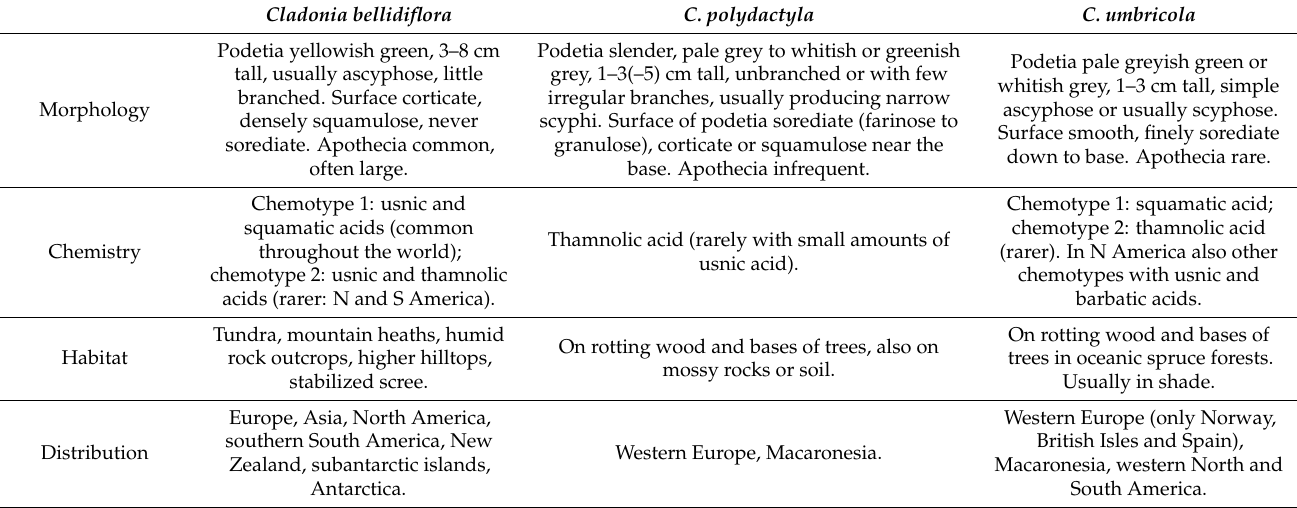
Table 1. Characterisation of Cladonia bellidiflora , C. polydactyla and C. umbricola based on Ahti et al. [16] and James